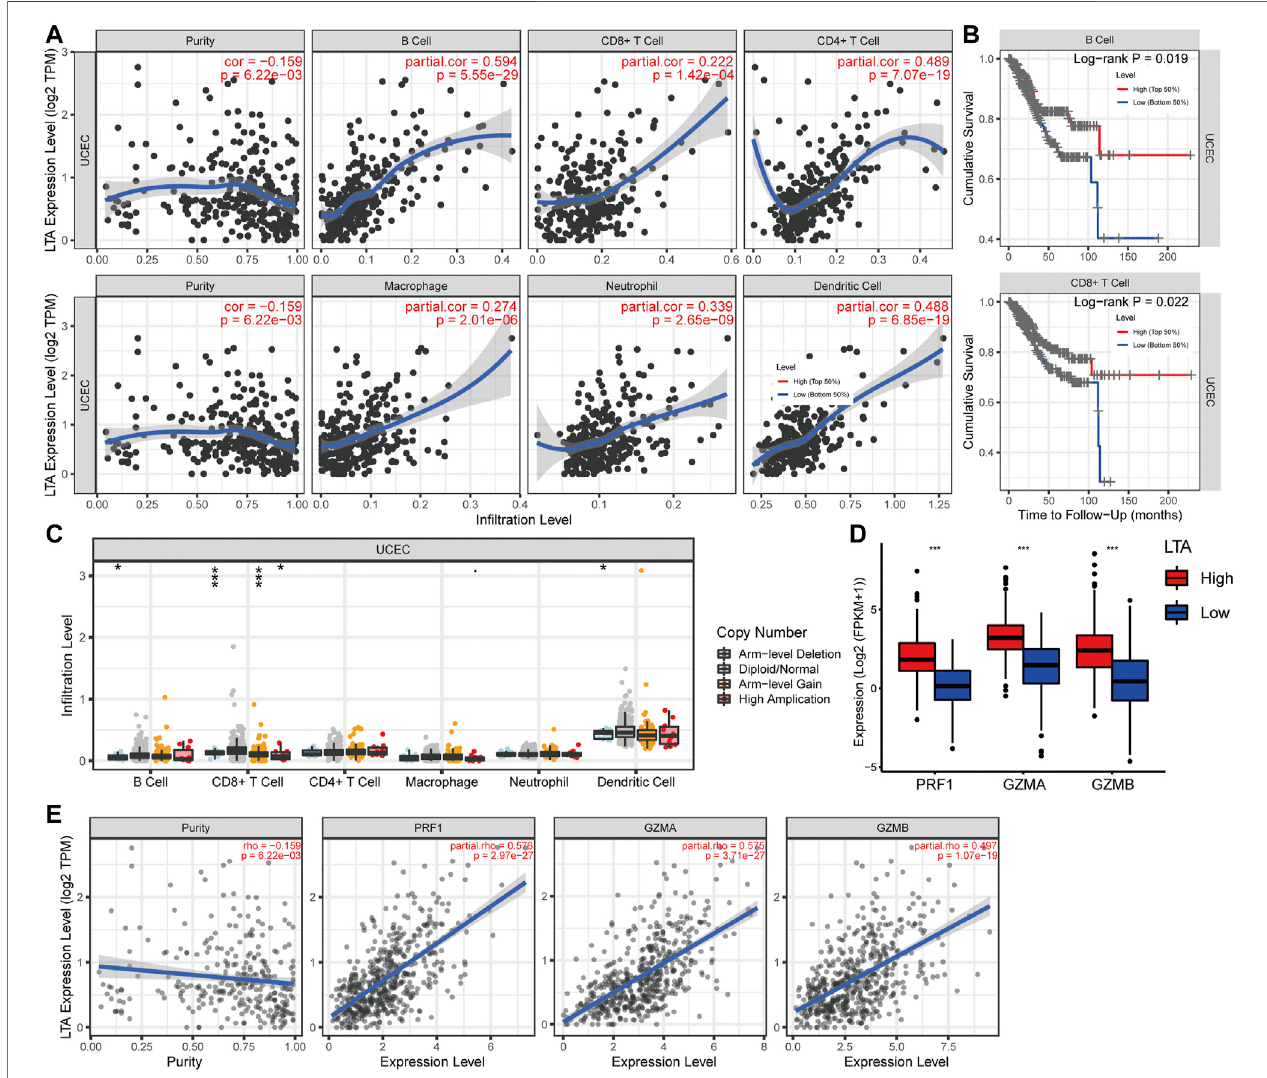
FIGURE 4 | Analysis of the correlation of LTA expression with TICs in UCEC using TIMER. (A) Six types of them were positively correlated with the expression of LTA,includingBcell,CD8 + Tcell,CD4 + Tcell,macrophage,neutrophil,anddendriticcell. (B) BcellandCD8 + Tcellweresigni fi cantlyassociatedwithprognosisofUCEC patients. (C) The impact of LTA on patients ’ somatic copy number (SCNA) alteration. (D,E) The relationship between LTA and the newly immune in fi ltration biomarkers (PRF1, GZMA and GZMB). The p -values were labeled by asterisks (ns, no signi fi cance, * p < 0.05, ** p < 0.01, *** p < 0.001).